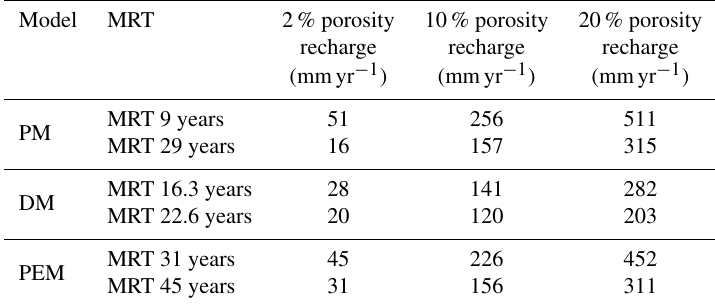
Table 5. Results of recharge rates (mmyr − 1 ) based on the maximum and minimum of the estimated MRT (years) obtained from PM, DM and PEM for Samia